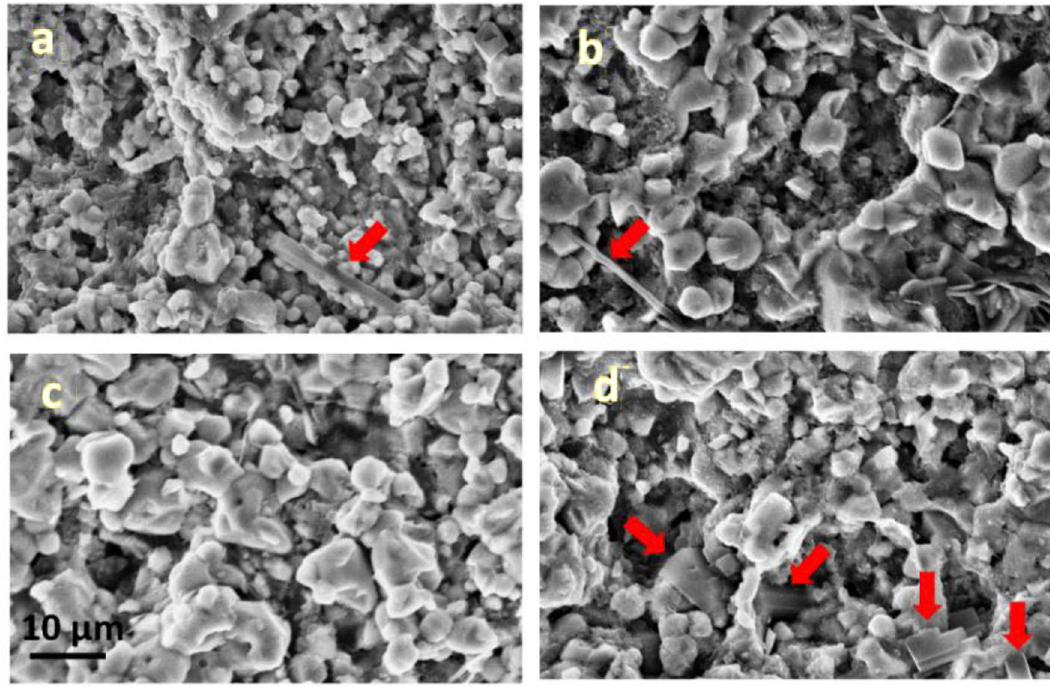
Fig. 7 SEM micrographs of HEO samples sintered at ( a ) 900 °C, ( b )1000 °C, ( c ) 1100 °C, and 1200 °C for a sintering time of 3